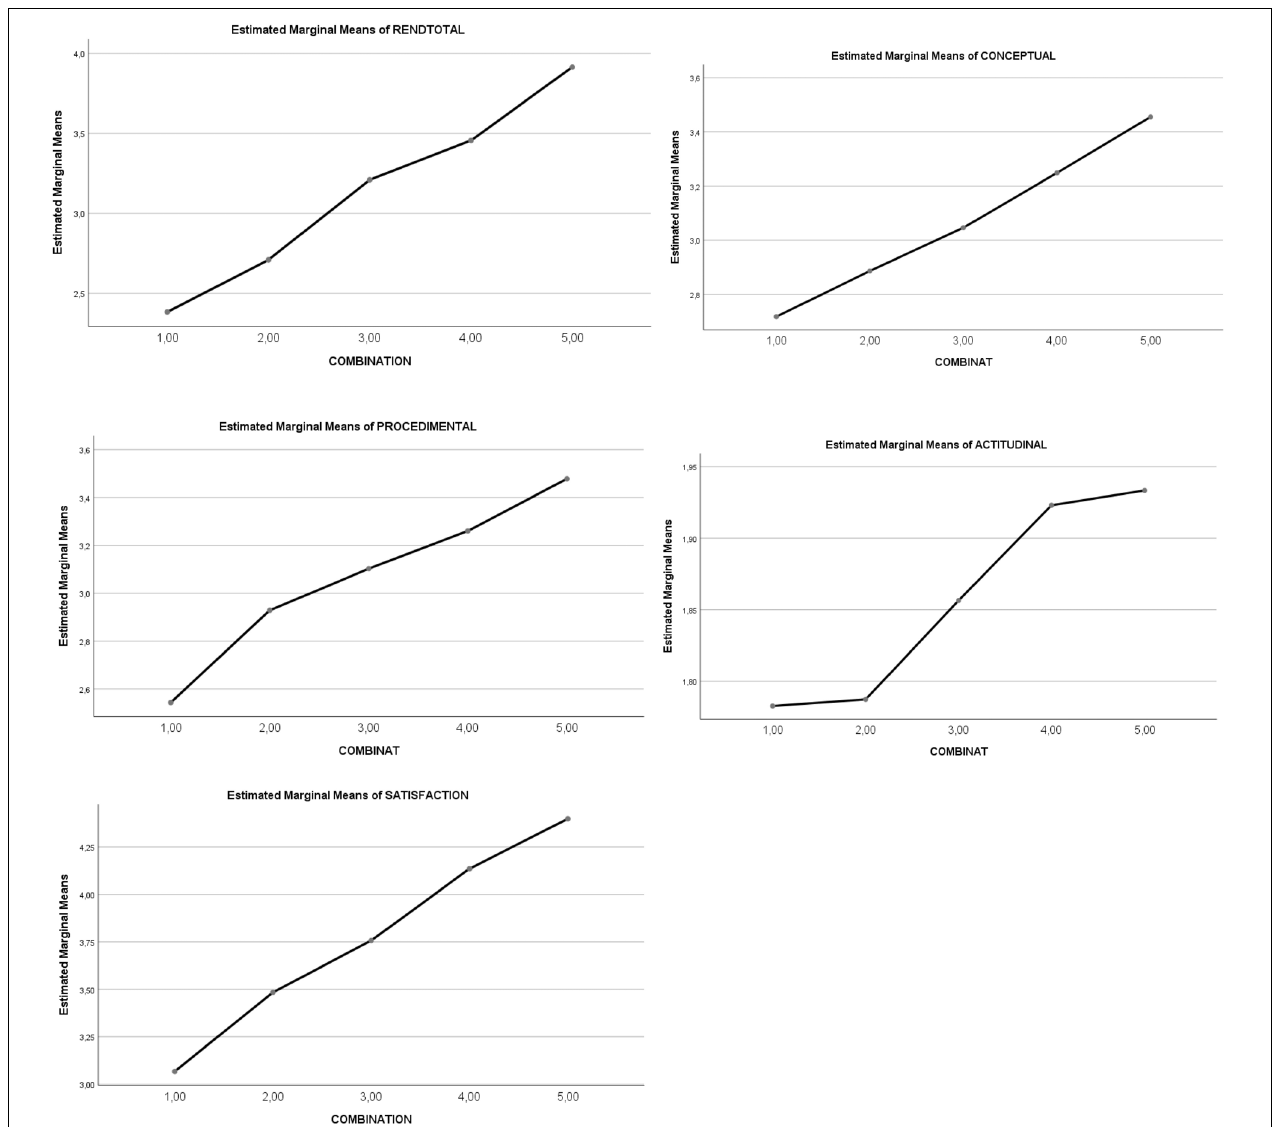
FIGURE 4 | Graphical representation of the effects of the combination types (heuristic levels 1–5) on academic achievement and